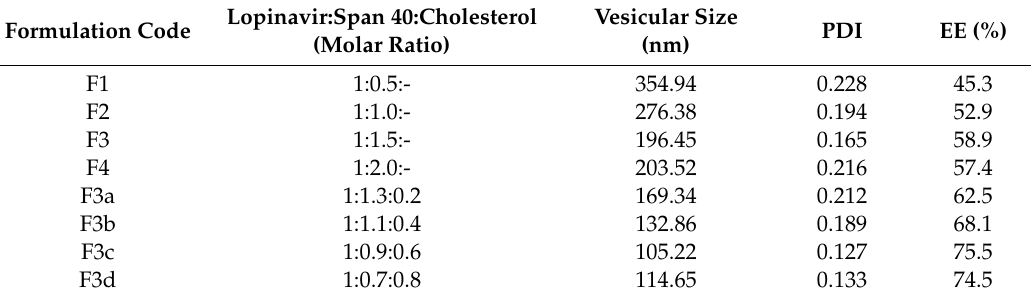
Table 10. Composition and characterization of lopinavir-loaded niosomal